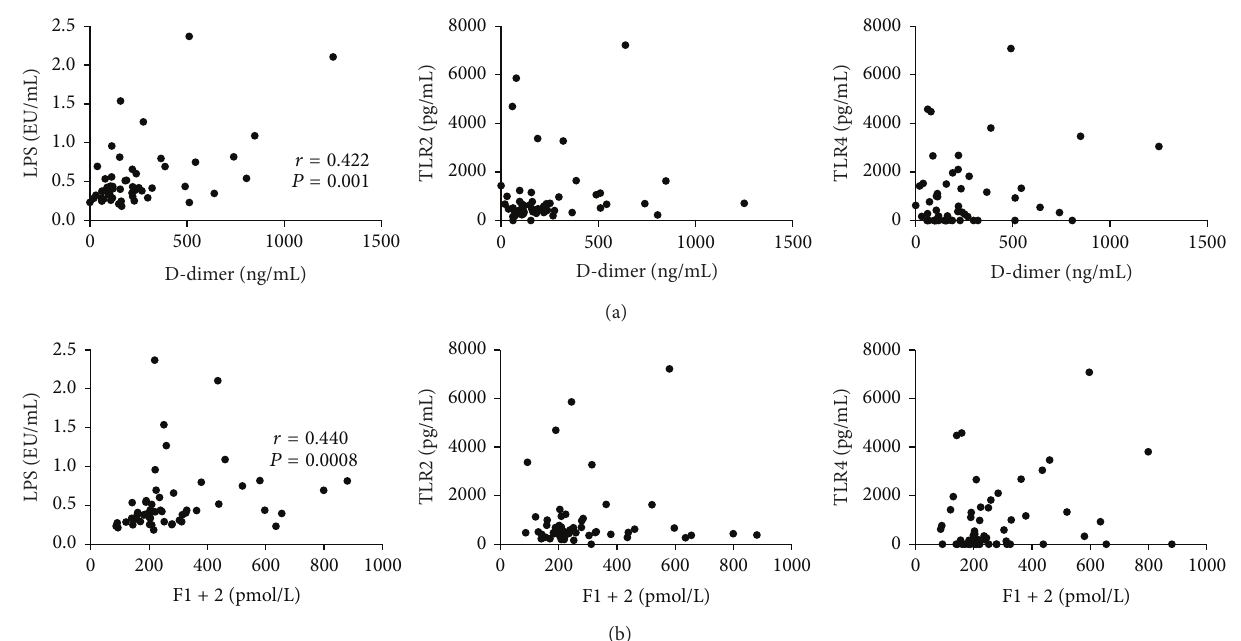
Figure 4: Circulating LPS correlates with markers of activated coagulation in IBD patients. Concentrations of LPS, TLR2, and TLR4 and levels of D-Dimer and prothrombin fragment F 1 + 2 were measured in the sera and plasma, respectively, of IBD patients. (a) Correlation between D-Dimer plasma levels and serum LPS, TLR2, and TLR4 in IBD patients. (b) Correlation between prothrombin fragment F 1+2 and circulating LPS, TLR2, and TLR4 in IBD patients. Statistical analysis was performed by means of Spearman Correlation Test. 𝑃 < 0.05 was considered statistically significant.